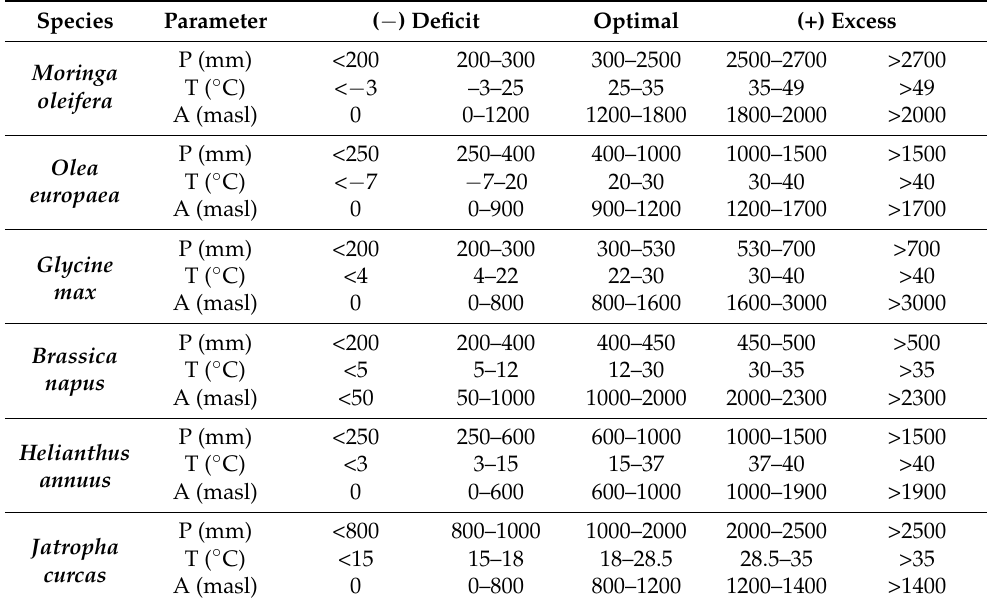
Table 2. Agroclimatic compatibility criteria of Moringa, Olive, Soybean, Rapeseed, Sunflower, and